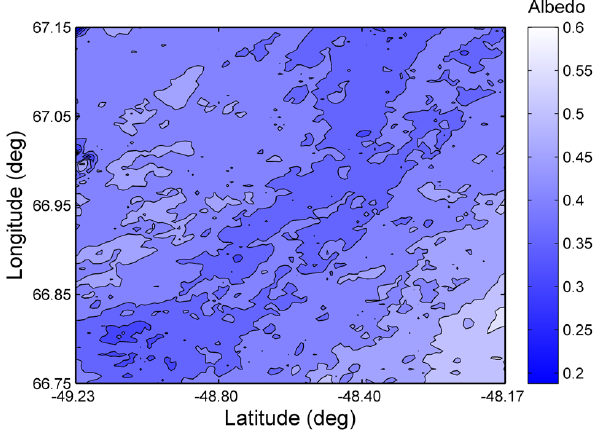
Figure 9. MODIS 2012 seasonal average albedo probability density distributions at three spatial extents. The MODIS 2012 seasonal av- erage albedo probabilities for the 100 × 100px and 150 × 150px re- veal a high probability of low albedo values (0.2–0.3). This is likely influenced by the expansion of the “dark-band” region in these spa- tial extents.